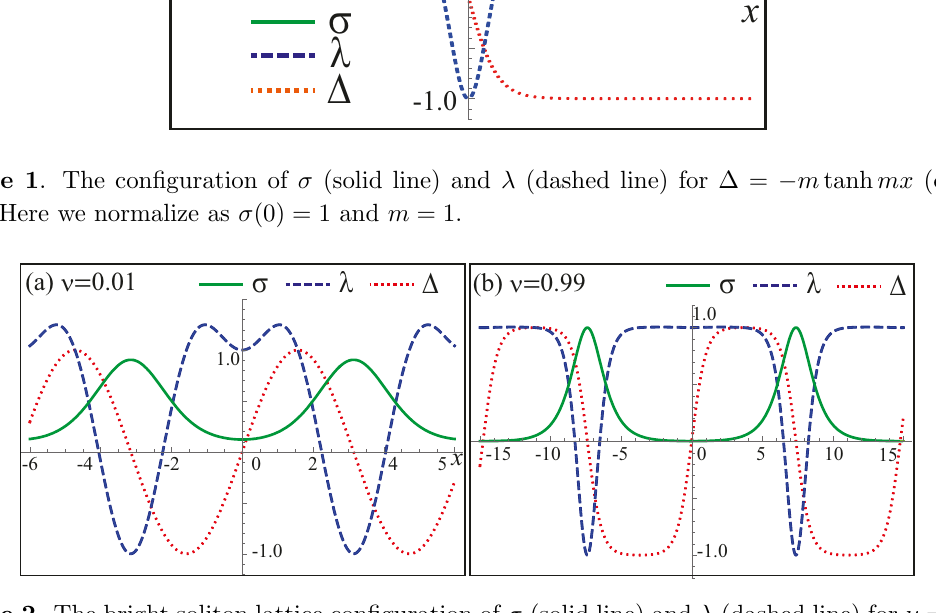
Figure 2 . The bright soliton lattice con(cid:12)guration of (cid:27) (solid line) and (cid:21) (dashed line) for (cid:23) = 10 (cid:0) 2 (left (cid:12)gure) and (cid:23) = 1 (cid:0) 10 (cid:0) 2 (right (cid:12)gure). The auxiliary (cid:12)eld (cid:1) (dotted line) are also plotted. Here we set, m = 1 and normalize the peak of (cid:27) to be